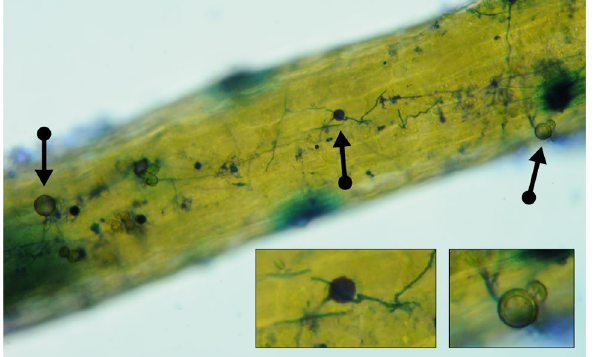
Figure 2. Structural evidence for mycorrhiza-like fungal associations. Host axis stained with methylene blue, showing structures having sizes and shapes consistent with interpretation as glomalean fungi. Aerial septate hyphae produce spherical spores of different developmental stages (arrows) and associated aseptate hyphae appear to occur beneath epidermal cell walls, forming blue-stained areas of sizes and shapes consistent with interpretation as finely-branched arbuscules